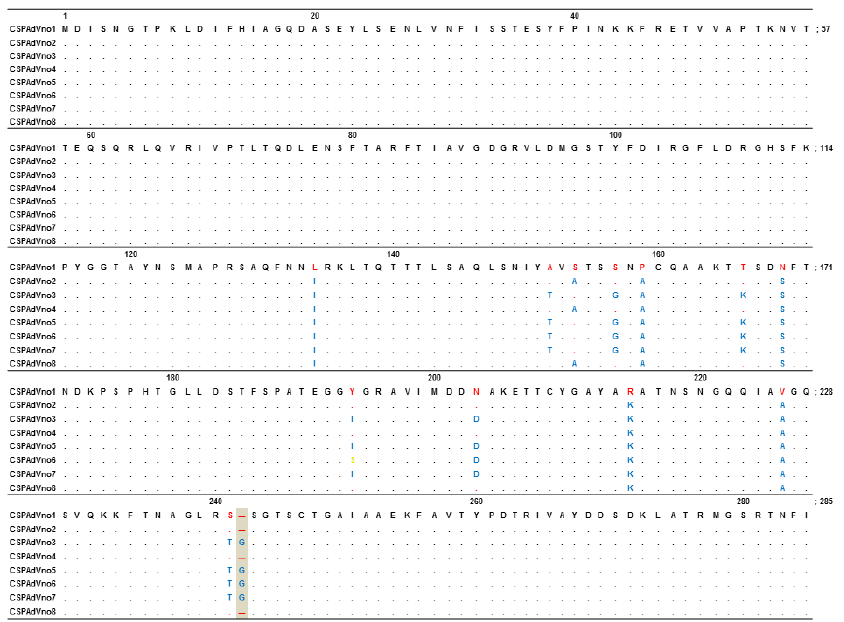
Figure 1. Differences of the amino acid sequence in the partial hexon gene of novel Chinstrap penguin adenoviruses. Within the 285-amino acid region, six amino acid changes were found between CSPAdVno1 and no2, no4 and no8 (residues 134, 154, 159, 169, 215 and 226), and 12-amino acid differences were found between CSPAdVno1 and no3, no5, no6 and no7 (residues 134, 152, 157, 159, 166, 169, 194, 203, 215, 226, 241 and 242). A deletion of an amino acid at position 242 was found in the hexon gene of CSPAdVno1, no2, no4 and no8 (gray rectangle, deletion of amino acid residue G; CAG, nucleotide sequences in 722–724